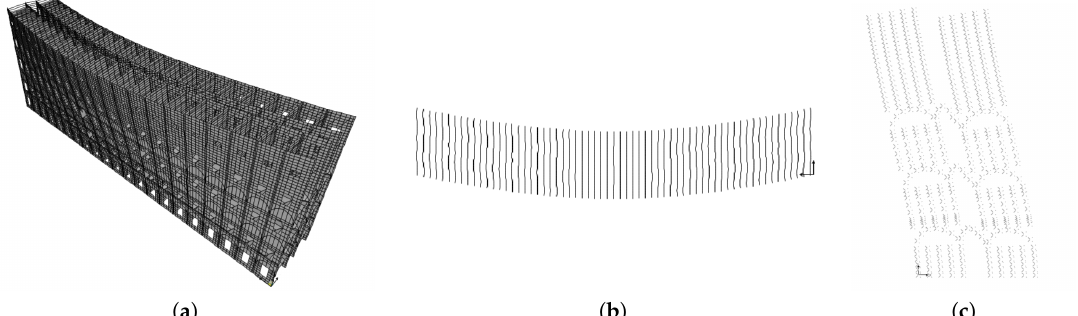
Figure 16. First natural mode of the LTW fine model. Natural frequency f = 1.38 Hz. Modal shape in the: ( a ) 3D space; ( b ) x − z plane; ( c ) y − z